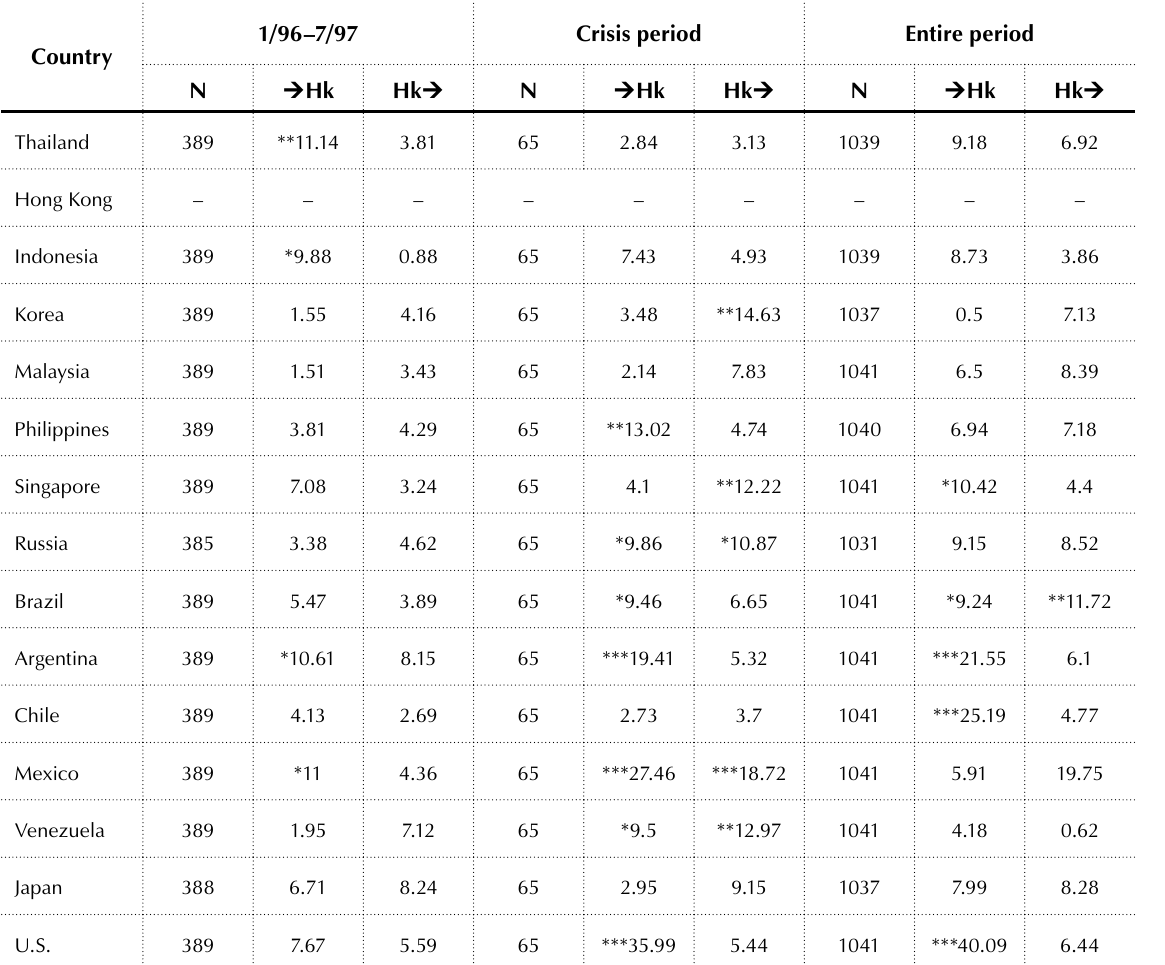
Table 3. Liquidity contagion after the Hong Kong crisis 1/96–7/97 Crisis period Entire period Country N  Hk Hk